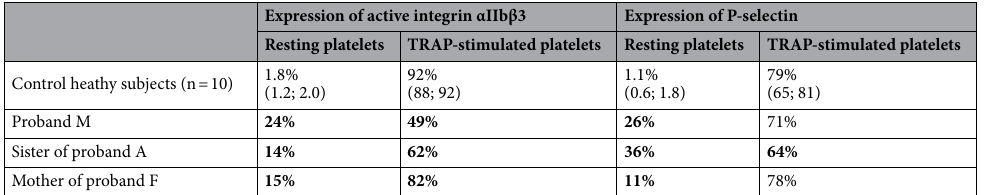
Table 4. Flow cytometry-measured expression of active integrin αIIbβ3 (mAb PAC-1 binding) and P-selectin in resting and stimulated platelets from the blood of patients with a MYH9 gene mutation. (1) Results are presented as fractions of platelets expressing active integrin αIIbβ3 or P-selectin; (2) the results for control heathy subjects are presented as the median and interquartile range (25th and 75th percentiles); (3) the numbers in bold are outside the normal ranges determined in control healthy